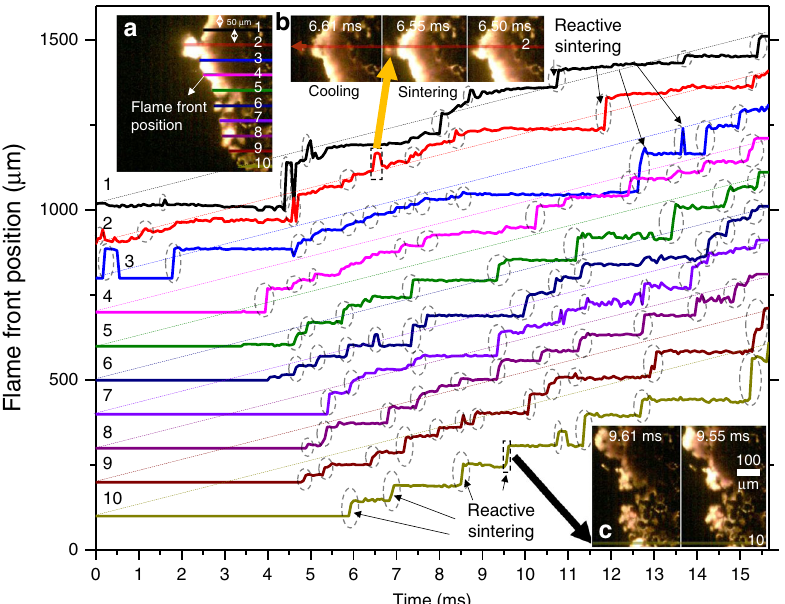
Fig. 6 Tracking the time-resolved fl ame front position (propagation direction is from right to left). Left-top inset ( a ) shows location where fl ame front is tracked and plotted and ordered 1 – 10, separated by 50 μ m. Inset b and c show two typical reactive sintering events. The reactive sintering events are annotated with the dashed circles on the line